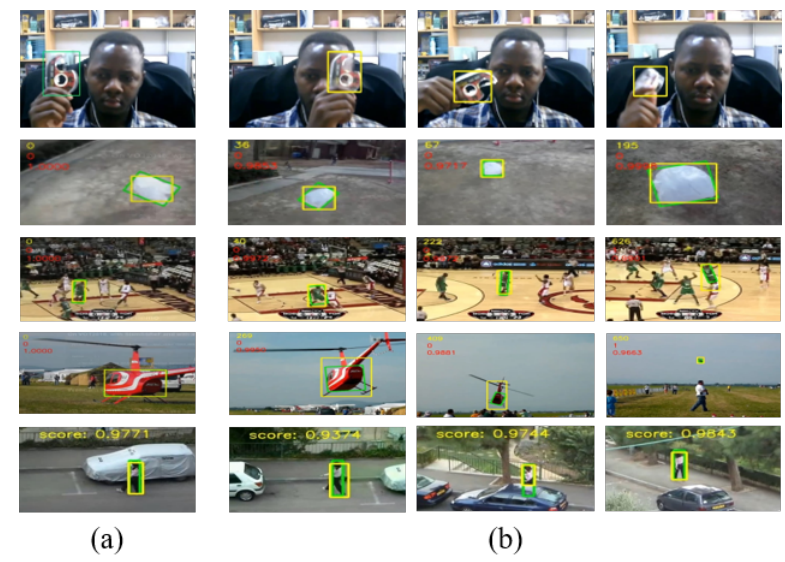
Figure 1. Illustration of the visual object tracking results: ( a ) The initial frame with a bounding box. ( b ) Tracking results in three different selected frames with the ground truth in green and ours in yellow bounding boxes. From top to bottom: Scotch tape webcam, Bag, Basketball, Helicopter and Woman, respectively. Apart from Scotch tape webcam, videos are from VOT2018 [9] and OTB2015 [10]